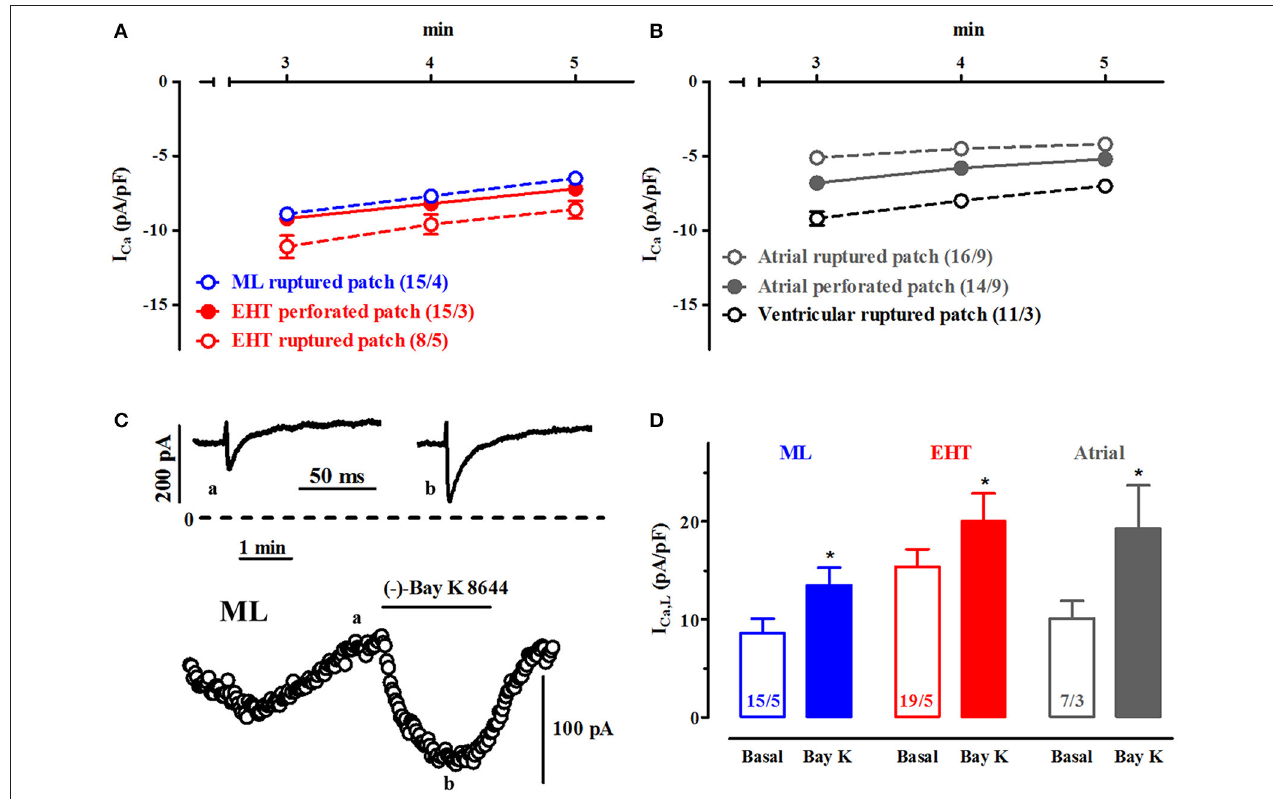
FIGURE 4 | Run-down and activation of ICa,L by ( − )-Bay K 8644 in ML and EHT. (A,B) Run-down of ICa: Mean ICa densities during the time frame of experiments in time-matched controls in ML and EHT (A) and in adult CM (B) (please note data for perforated patch given with closed symbols). (C,D) Effects of ( − )-Bay K 8644: (C) Time-course and original tracings for time points a and b of ICa,L in response to 10 µ M ( − )-Bay K 8644 in ML. (D) Mean values for ICa,L before and after ( − )-Bay K 8644 (10 µ M) in ML, EHT and atrial CM (* indicates p < 0.05 vs. respective basal values). N/N indicates number of cells vs. number of isolation for ML and EHT and number of cells/number patients for atrial